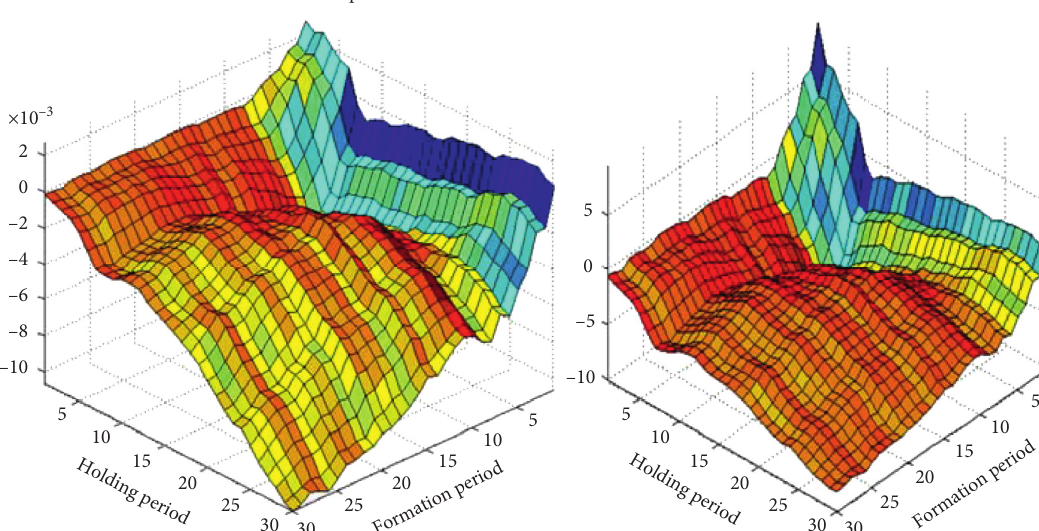
Figure 5: Highest accumulative relative order imbalance in extensions of the A-share market. This figure plots the daily momentum profits and their t -statistics under the highest accumulative relative order imbalance in A-share market. The formation and holding periods, respectively, range from 1 day to 30